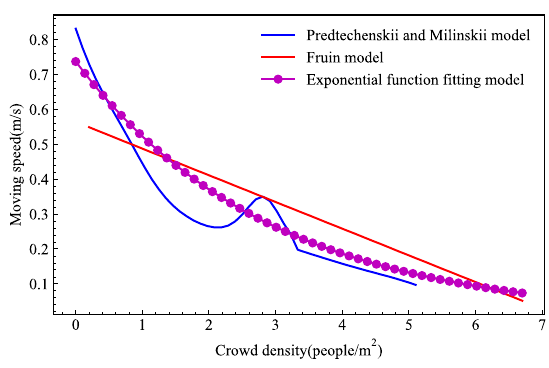
Figure 9. The fitting model of the moving speed of evacuees ascending stairs.